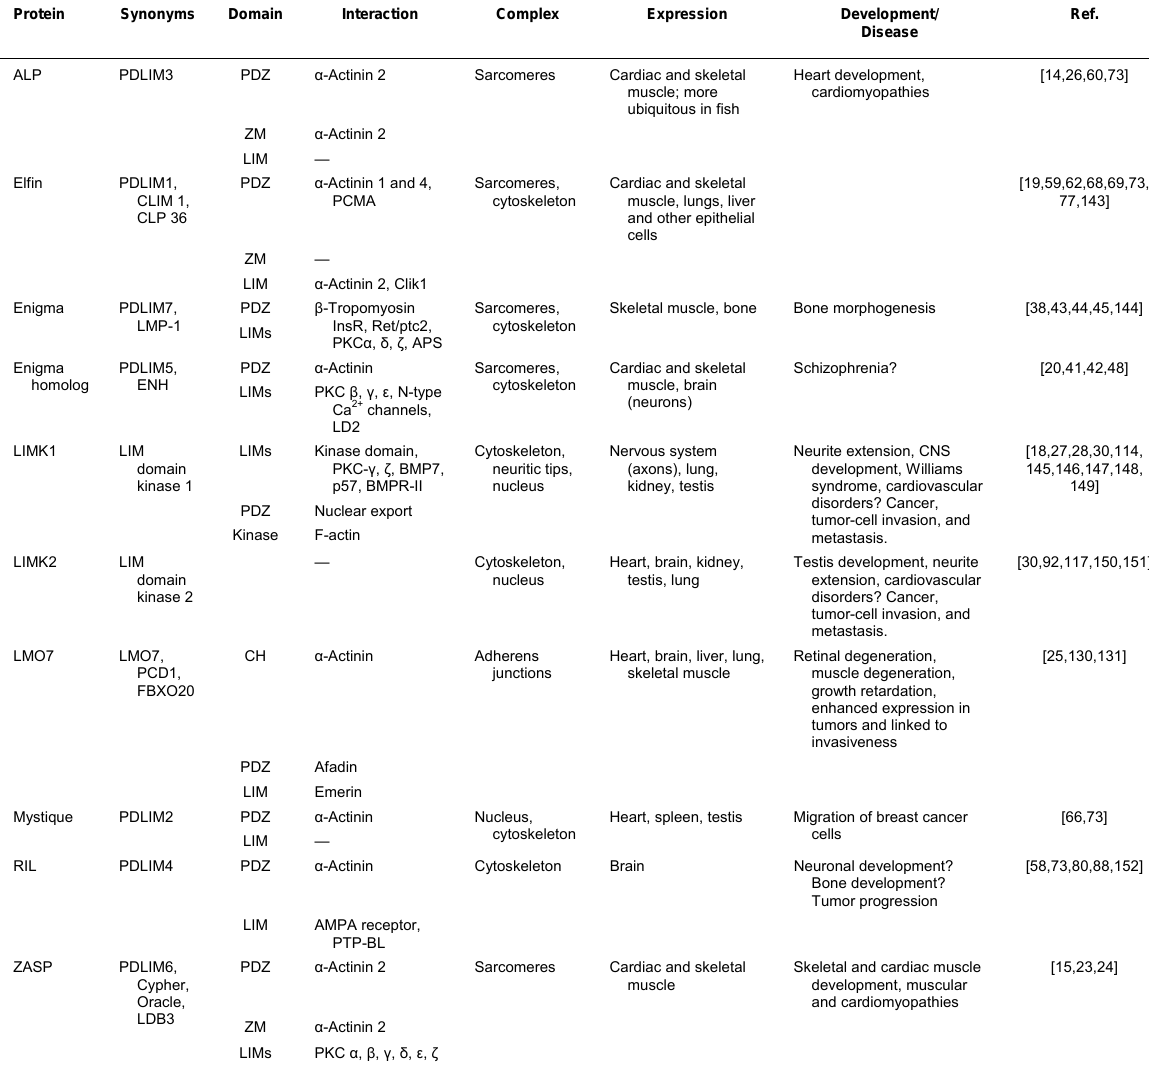
Cardiac and skeletal muscle